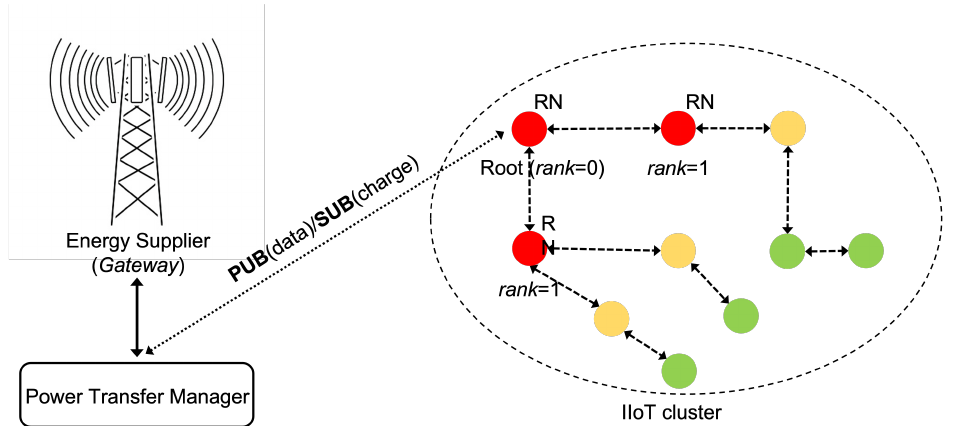
Figure 1. High level architecture comprising the Energy Supplier node and the Power Transfer Manager which jointly handle the WPT procedure for an IIoT cluster arranged in a tree-wise topology, in the presence of Rechargeable